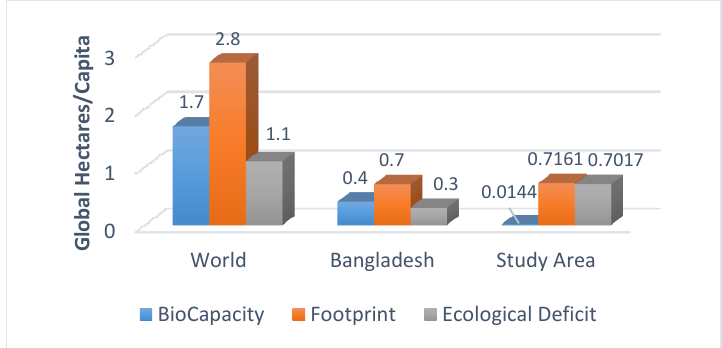
Figure 14. Global, National, and Local Perspectives of the Ecological Deficit.